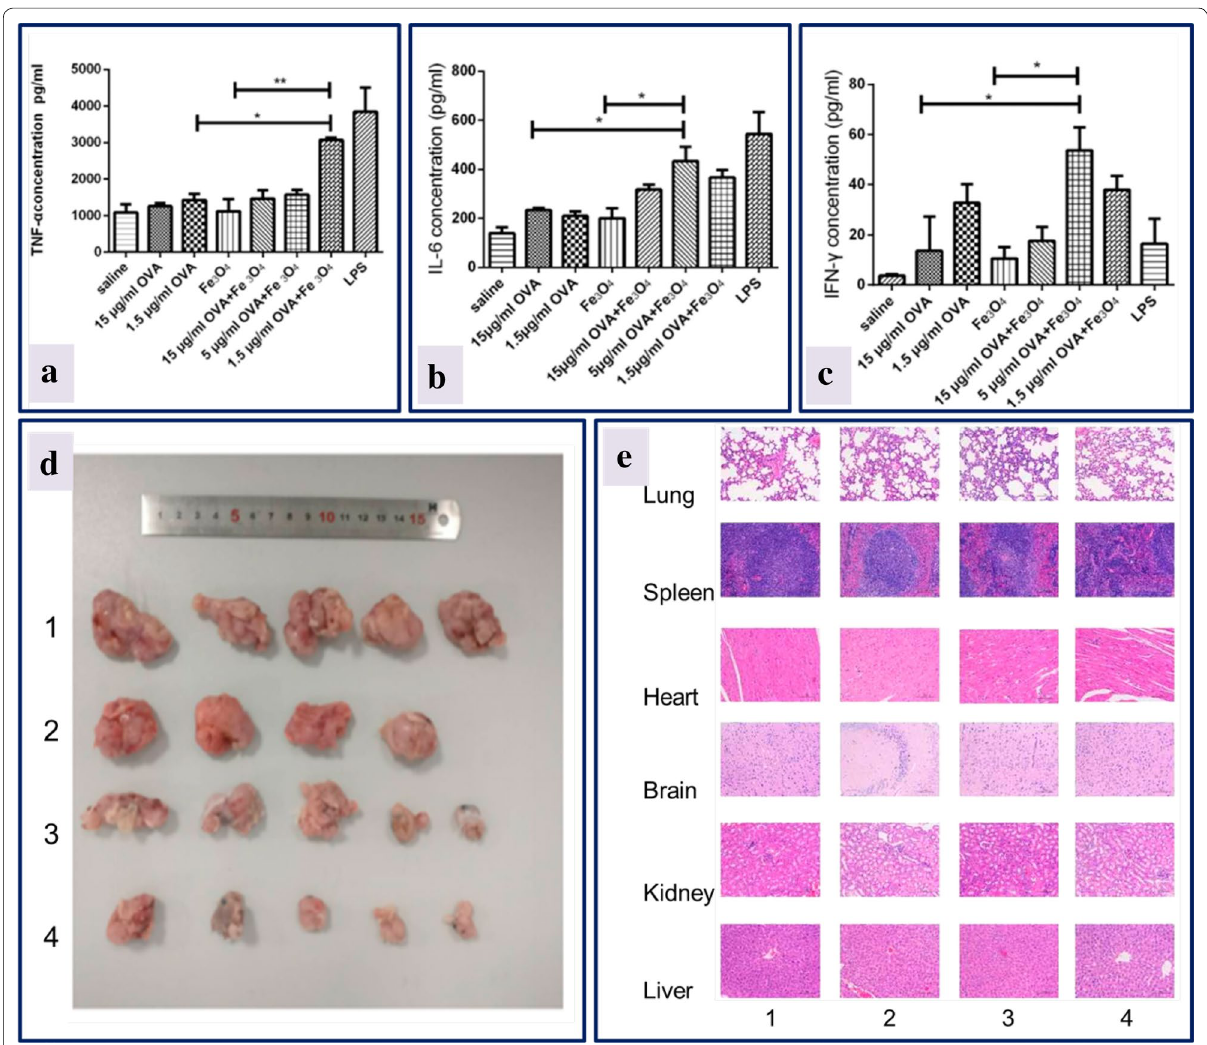
Fig. 6 Effect of OVA-iron oxide nanoparticles: macrophages activation with different concentrations of OVA, and production of a TNF-α, b IL-6, c IFN-γ. Saline and LPS served as negative and positive control; d size of the tumor measured after 22nd day of mice immunization; e histological sections of different organs on 23rd day after immunization of mice with different treatments (1) control, (2) soluble OVA, (3) iron oxide nanoparticles and (4) OVA-iron oxide nanoparticles (reproduced with permission from